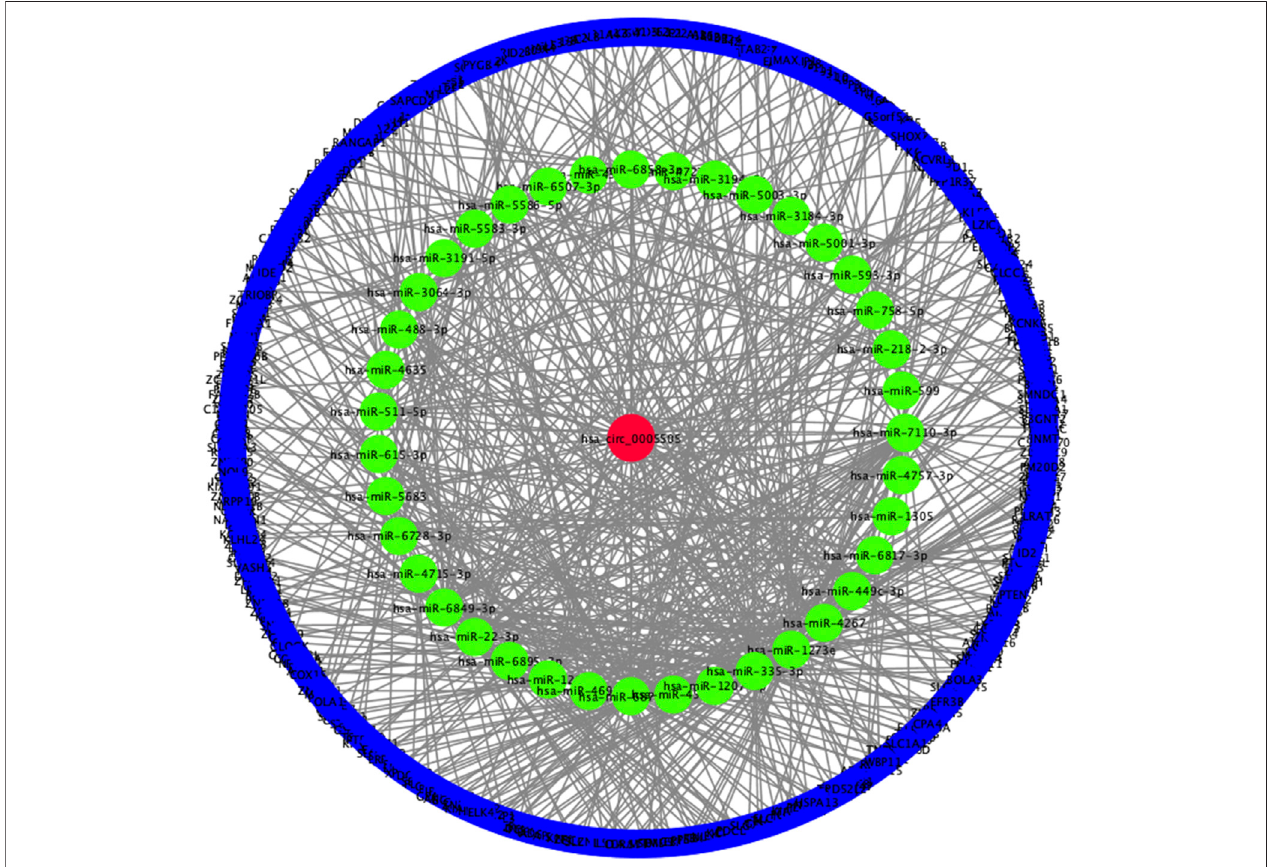
FIGURE 7 | Constructed hsa_circ_0005505 − miRNA − mRNA network. Red ellipse: hsa_circ_0005505, green ellipse: miRNAs potentially interacted with hsa_circ_0005505, blue ellipse: genes positively co-expressed with hsa_circ_0005505.